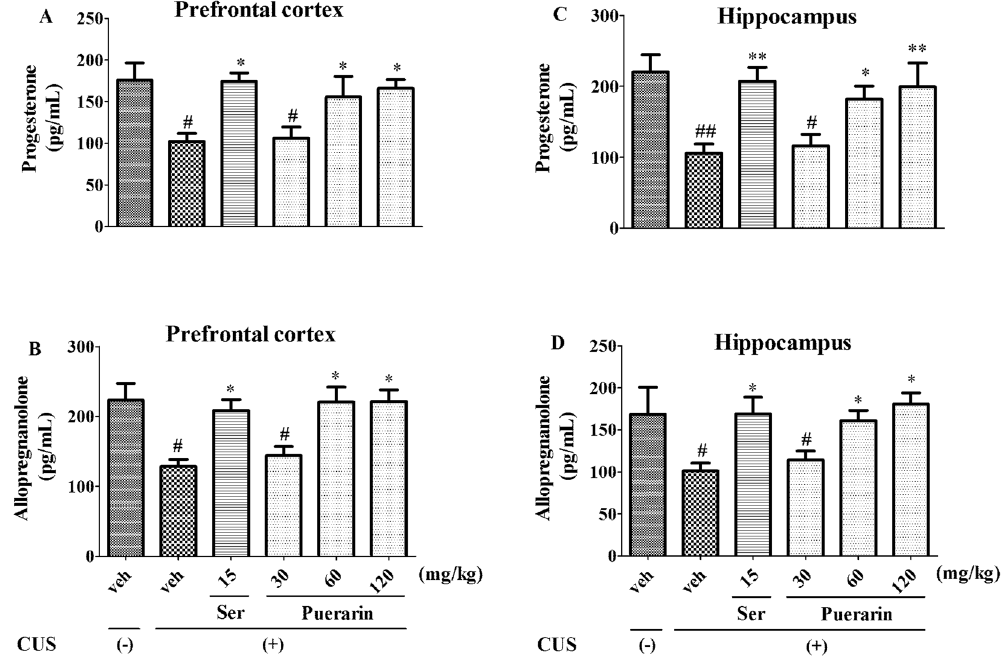
Figure 6. The effects of puerarin on levels of progesterone and allopregnanolone in the prefrontal cortex ( A , C ) and hippocampus ( B , D ), respectively. # p < 0.05, ## p < 0.01 vs. vehicle-treated CUS ( − ) group; * p < 0.05, ** p < 0.01 vs. vehicle-treated CUS ( + ) group (n = 6 per